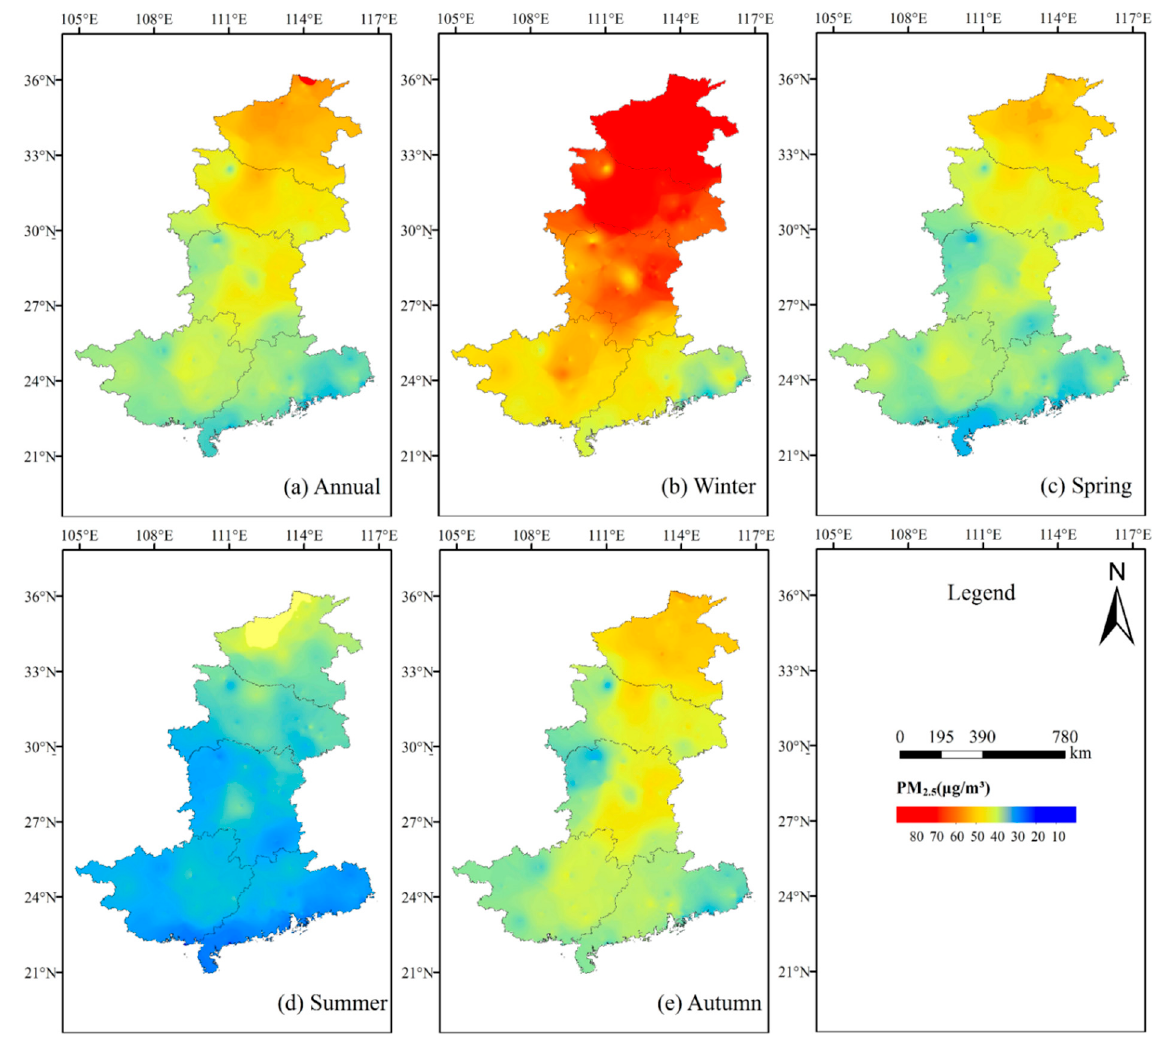
Figure 3. Distribution of PM 2.5 : ( a ) Annual, ( b ) Winter, ( c ) Spring, ( d ) Summer, ( e ) Autumn.